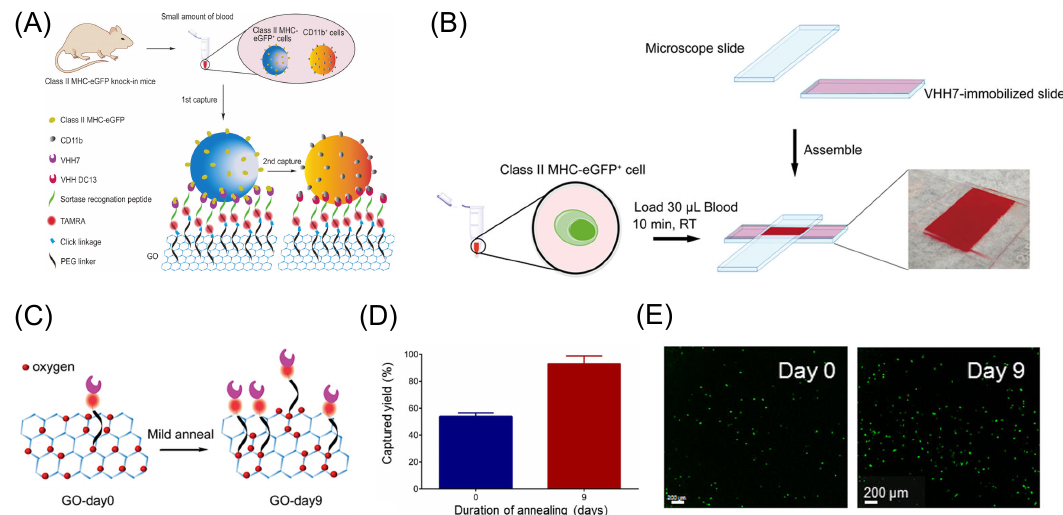
Figure 9. ( A ) Schematic of VHH7 and VHH DC13-based GO substrates for capture of Class II MHC-eGFP+ and CD11b+ cells from whole blood. ( B ) Schematic of the cell capture device made from glass slides, the assay conditions, and a digital photograph of the constructed and loaded capture chamber. ( C ) Schematic showing enhanced functionalization of GO nanosheets because of oxygen clustering on the graphene basal plane. GO-Day 0 represents as-synthesized GO sheets with no annealing treatment, while GO-Day 9 represents GO substrates annealed for 9 days at 80 ◦ C to induce oxygen clustering. ( D ) Cell capture efficiency of annealed GO structure (Day 9) compared to that of as-synthesized structure (day 0). ( E ) Quantification of captured class II MHC-positive eGFP+ cells from murine whole blood samples comparing Day 0 and Day 9 samples. Figures reproduced with (cid:13) (cid:13) ; and ( B – E ) [35], ACS c permission from: ( A ) [153], Wiley c